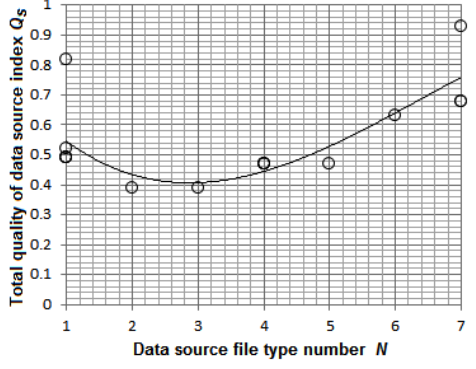
Fig. 1. Total quality index Q t values for the successive groups of data sources N : 1 – raster graphic files, 2 – vector files ESRI Shape type with simplified scale of data (MIZ), 3 – vector files KMZ type with simpli - fied scale of data (MIZ), 4 – vector ESRI Shape type file with extended scale of data (SIGRID-3), 5 – vector GML type files according to S-411 standard, 6 – text files with ordered data series, 7 – gridded GRIB